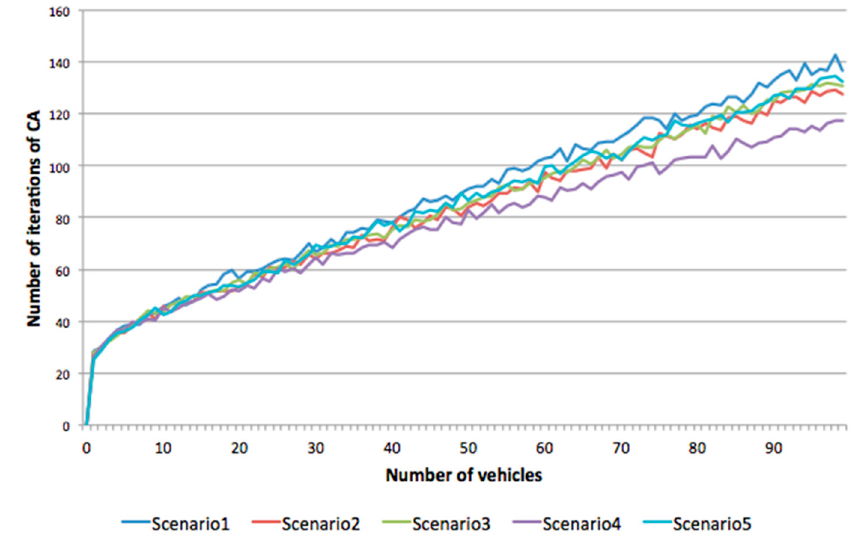
Figure 15. Examination of the impact of the number of vehicles moving on wet surfaces on roundabout capacity, as per various traffic scenarios.